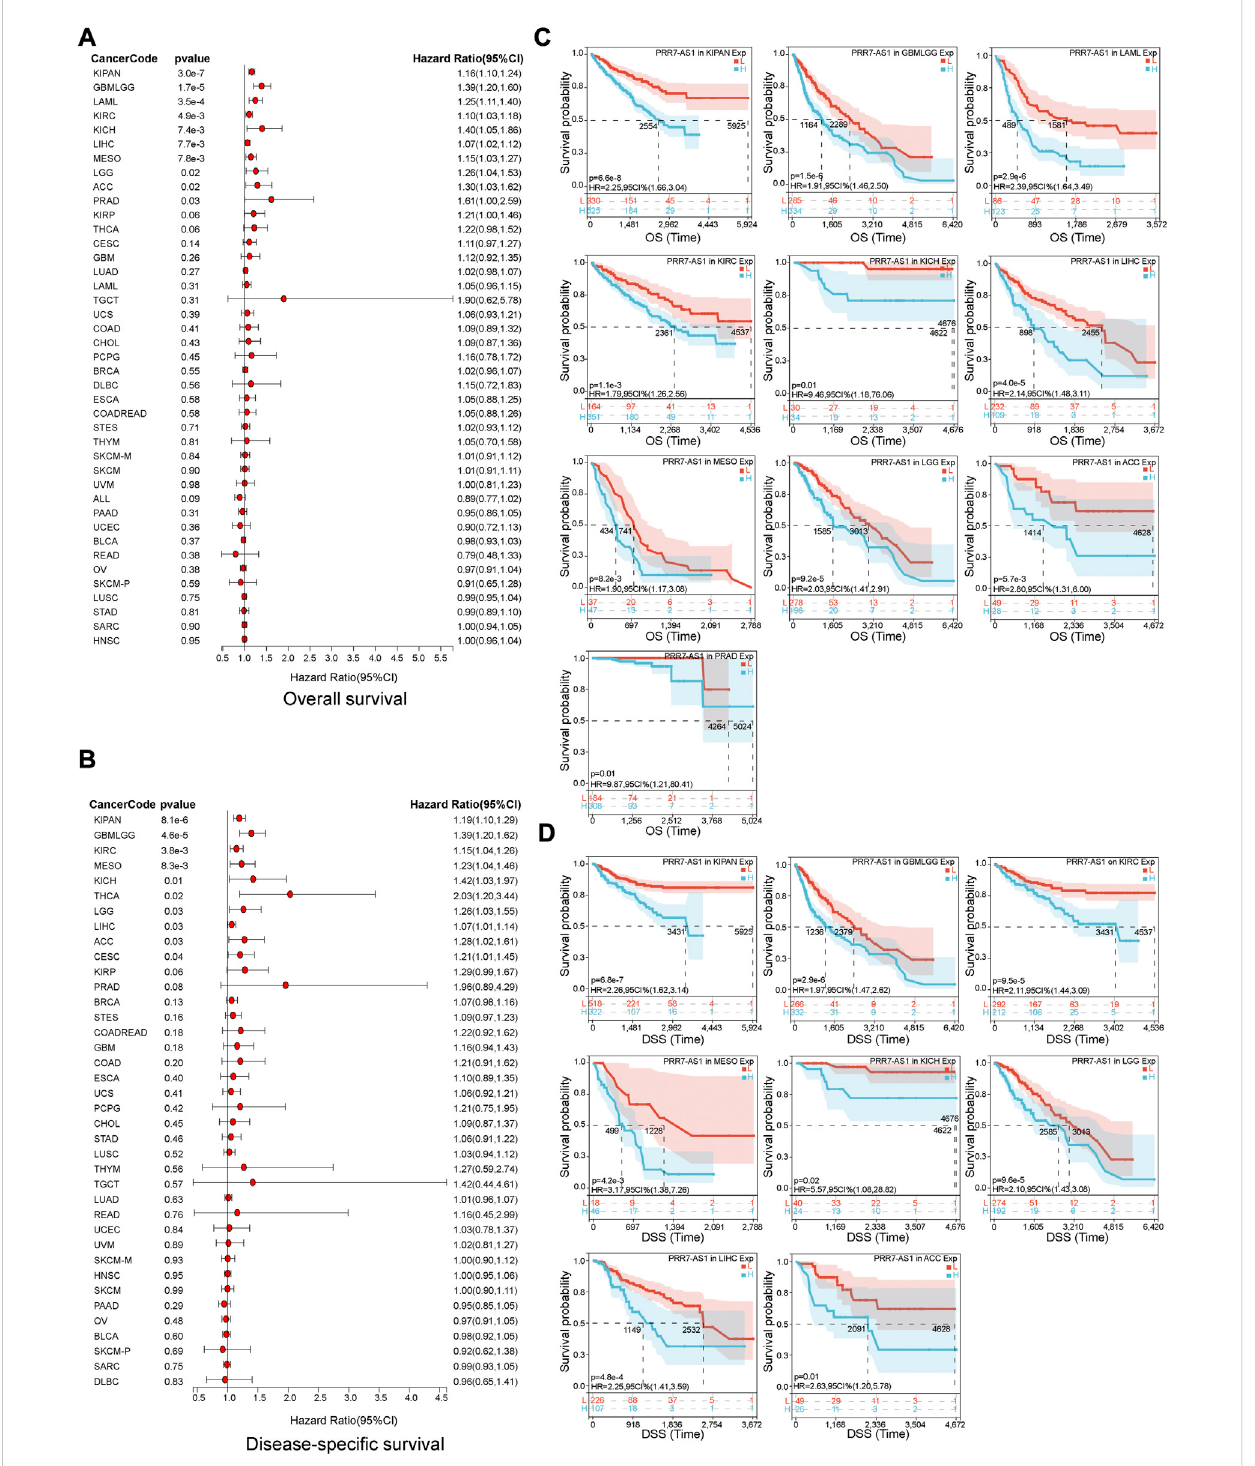
Prognostic value of PRR7-AS1 for overall survival (OS) and disease-speci fi c survival (DSS) in pan-cancer. The forest plots showing the results of Cox regression analysis for (A) OS and (B) DSS. Kaplan-Meier analysis of (C) OS and (D) DSS for PRR7-AS1 in different